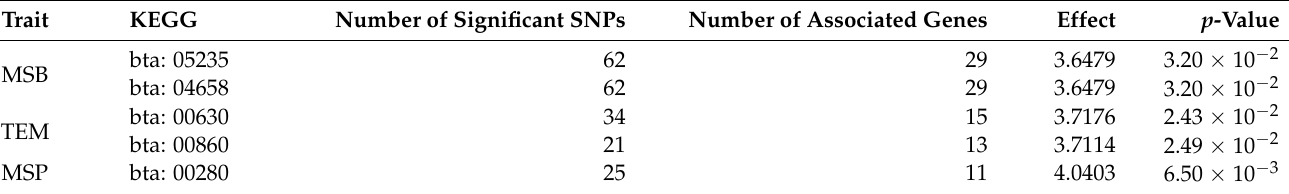
Figure 4. GWAS results for maternal stillbirth. The red line (1.96) represents a nominal and the blue line (4.88) a Bonferroni-corrected critical value corresponding with a 5% significance level. Table 3. Significant KEGG pathways.